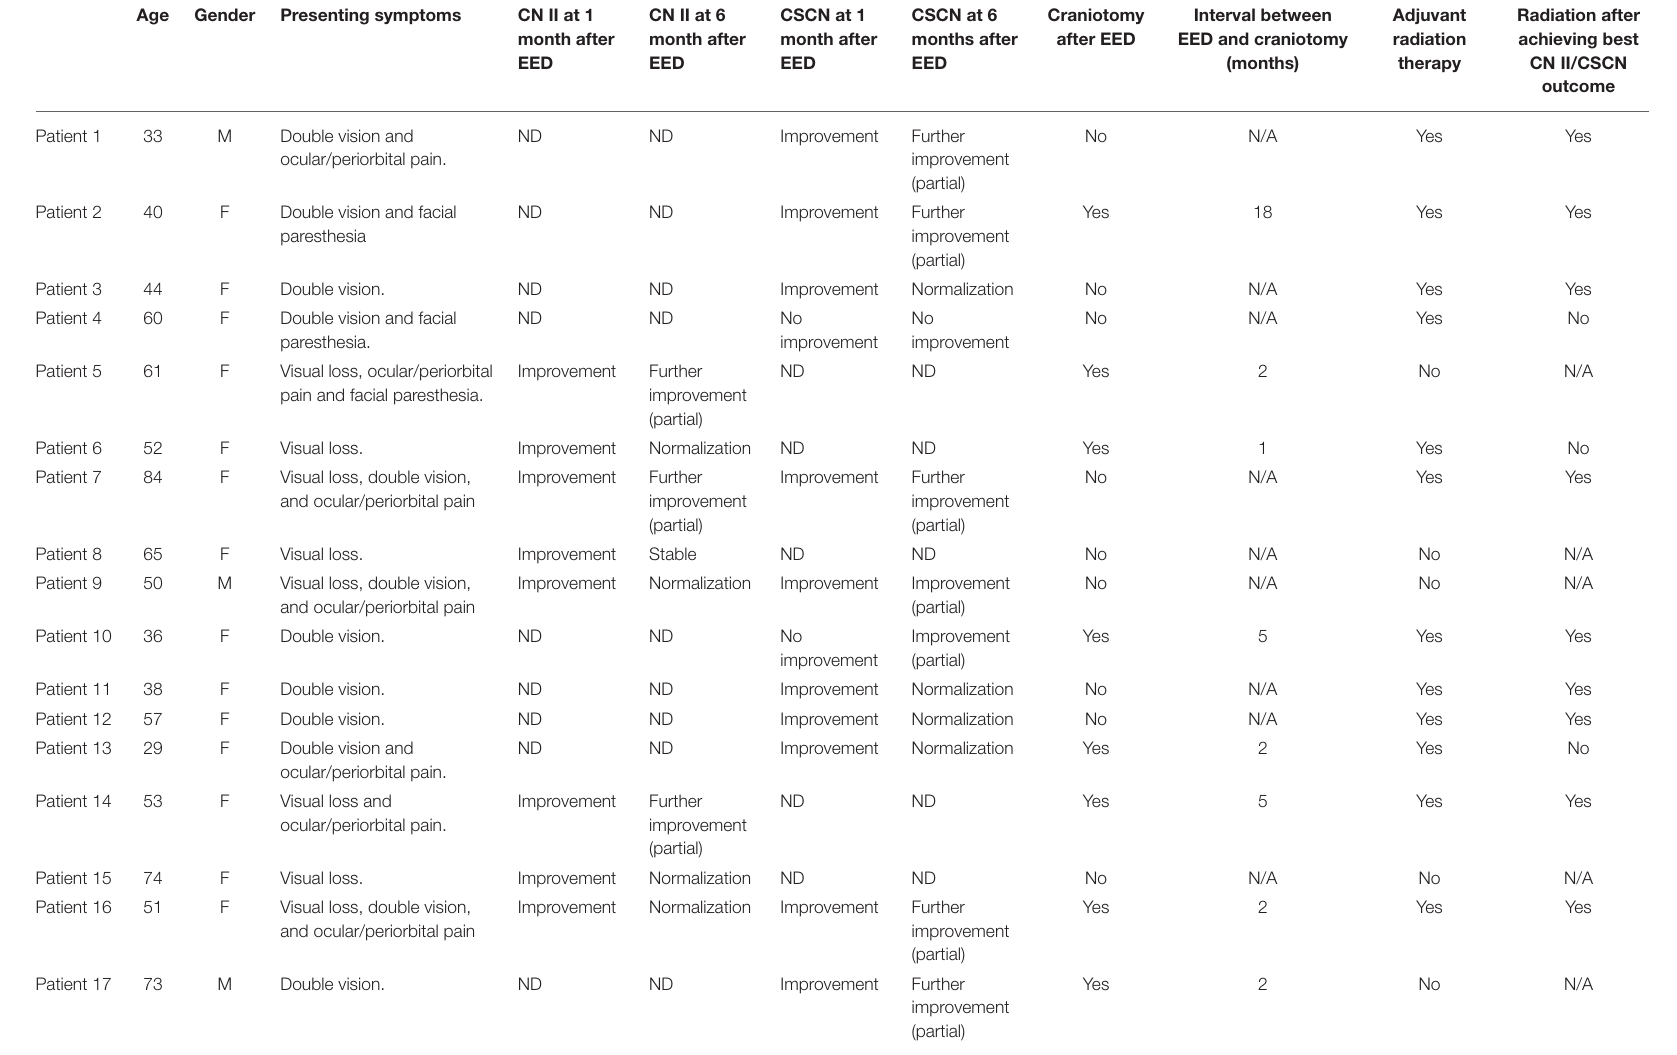
TABLE 1 | Detailed cranial nerve outcomes of the series with the timeline of endoscopic endonasal decompression (EED), craniotomy, and radiation therapy. Age